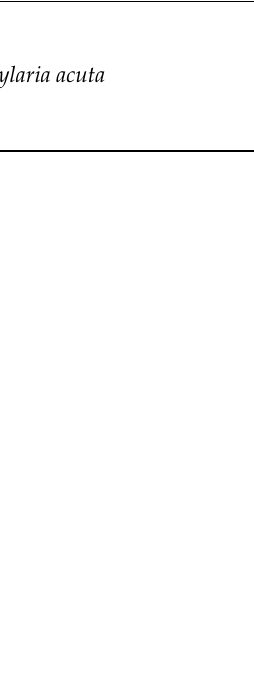
Table 4. Summary of the algal-mediated synthesis of zinc oxide